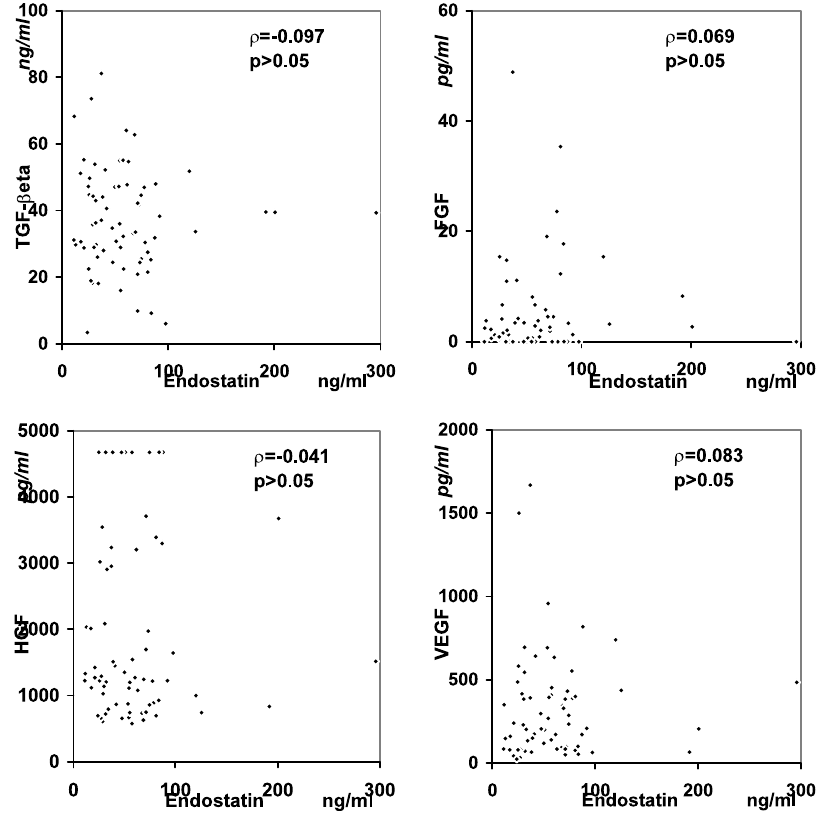
FIG. 1. Correlation between serum levels of endostatin and VEGF, HGF, TGF- b 1 and